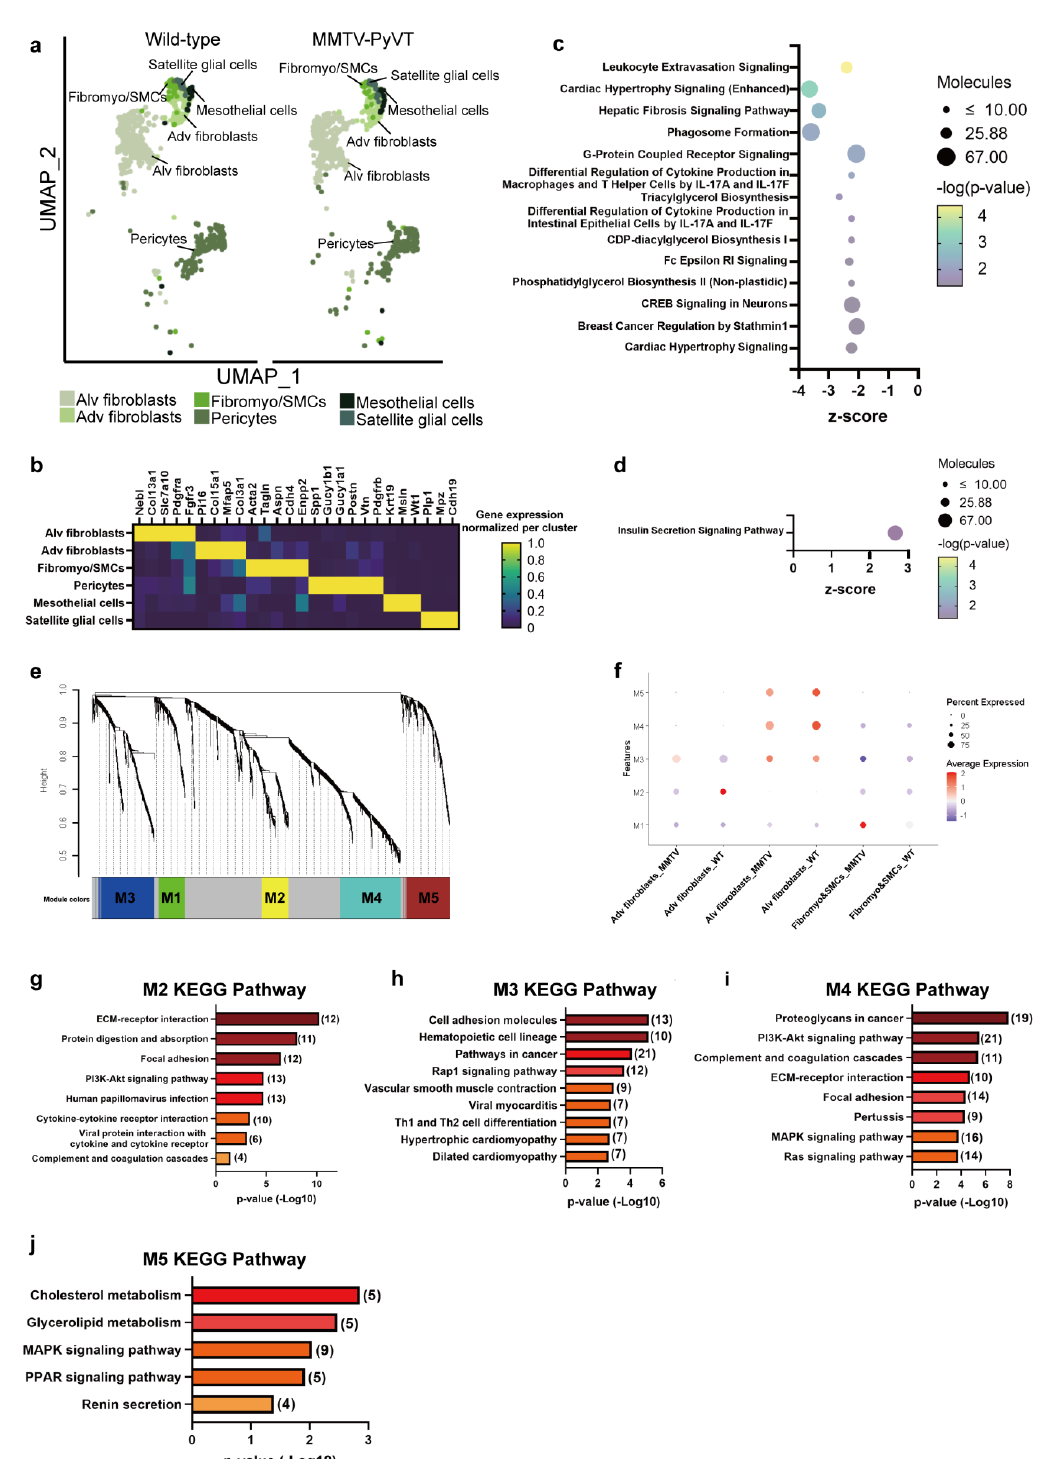
Figure 6. Detection of stromal clusters in the lungs of MMTV-PyVT mice. ( a ) Subpopulation of stromal cells (fibroblasts, pericytes, mesothelial cells and satellite glial cells) in the lungs of wild-type and MMTV-PyVT mice. ( b ) Biomarkers of stromal cells. Pathway analysis of ( c ) alv fibroblasts and ( d ) adv fibroblasts. ( e ) WGCNA of lung fibroblasts. ( f ) Correlation analysis between WGCNA modules and the subpopulations of lung fibroblasts. KEGG pathways ( g ) M2, ( h ) M3, ( i ) M4 and ( j ) M5